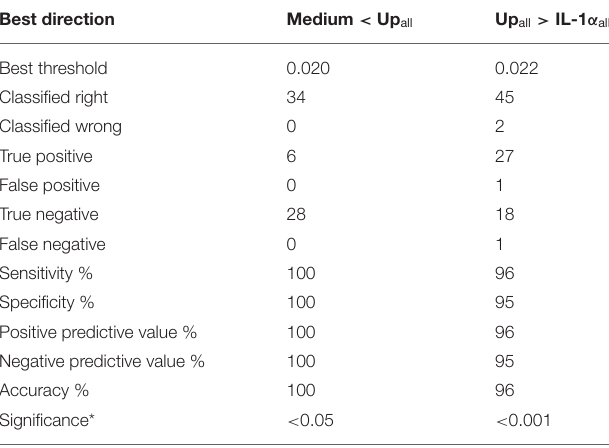
TABLE 1 | Statistical analyses for peak 100